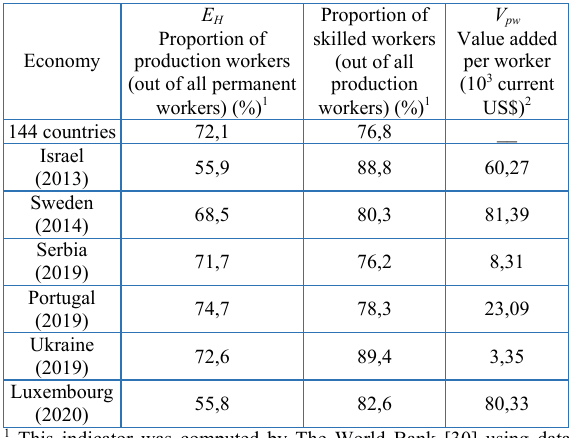
Table 5. Value added by production workers in several countries. Economy